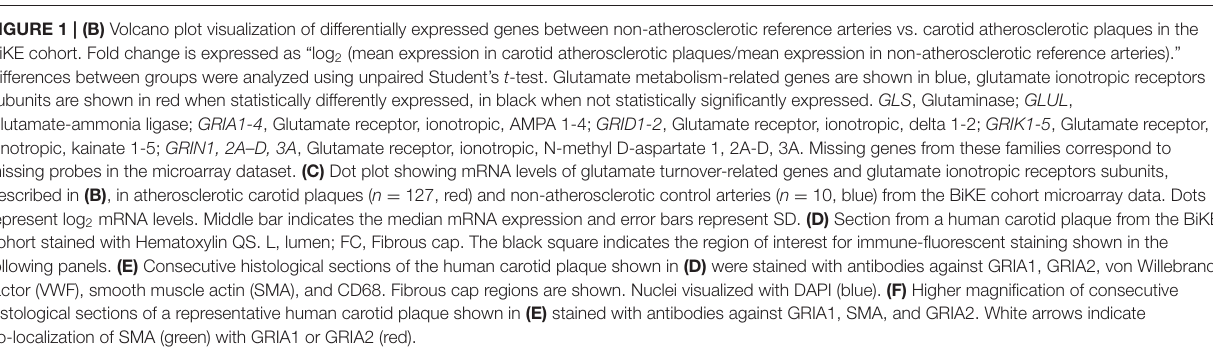
FIGURE 1 | (B) Volcano plot visualization of differentially expressed genes between non-atherosclerotic reference arteries vs. carotid atherosclerotic plaques in the BiKE cohort. Fold change is expressed as “log 2 (mean expression in carotid atherosclerotic plaques/mean expression in non-atherosclerotic reference arteries).” Differences between groups were analyzed using unpaired Student’s t -test. Glutamate metabolism-related genes are shown in blue, glutamate ionotropic receptors subunits are shown in red when statistically differently expressed, in black when not statistically significantly expressed. GLS , Glutaminase; GLUL , Glutamate-ammonia ligase; GRIA1-4 , Glutamate receptor, ionotropic, AMPA 1-4; GRID1-2 , Glutamate receptor, ionotropic, delta 1-2; GRIK1-5 , Glutamate receptor, ionotropic, kainate 1-5; GRIN1, 2A–D, 3A , Glutamate receptor, ionotropic, N-methyl D-aspartate 1, 2A-D, 3A. Missing genes from these families correspond to missing probes in the microarray dataset. (C) Dot plot showing mRNA levels of glutamate turnover-related genes and glutamate ionotropic receptors subunits, described in (B) , in atherosclerotic carotid plaques ( n = 127, red) and non-atherosclerotic control arteries ( n = 10, blue) from the BiKE cohort microarray data. Dots represent log 2 mRNA levels. Middle bar indicates the median mRNA expression and error bars represent SD. (D) Section from a human carotid plaque from the BiKE cohort stained with Hematoxylin QS. L, lumen; FC, Fibrous cap. The black square indicates the region of interest for immune-fluorescent staining shown in the following panels. (E) Consecutive histological sections of the human carotid plaque shown in (D) were stained with antibodies against GRIA1, GRIA2, von Willebrand factor (VWF), smooth muscle actin (SMA), and CD68. Fibrous cap regions are shown. Nuclei visualized with DAPI (blue). (F) Higher magnification of consecutive histological sections of a representative human carotid plaque shown in (E) stained with antibodies against GRIA1, SMA, and GRIA2. White arrows indicate co-localization of SMA (green) with GRIA1 or GRIA2